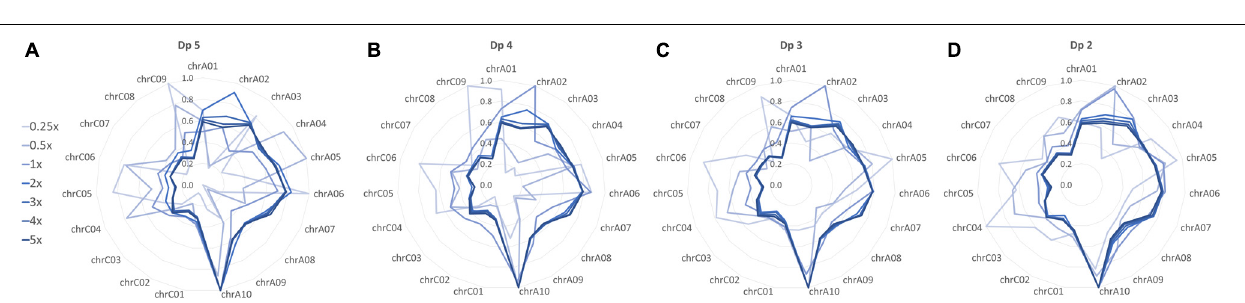
FIGURE 2 | Relative distribution of high-confidence SNPs across chromosomes in the global diversity panel skim SNP sets filtered to a minimum read depth of (A) dp 5, (B) dp 4, (C) dp 3, and (D) dp 2. SNP density between chromosomes within each SNP set (skim coverage level and depth filter combination) was compared, with the highest SNP density assigned a value of 1 and all other chromosomes assigned a value relative to this.